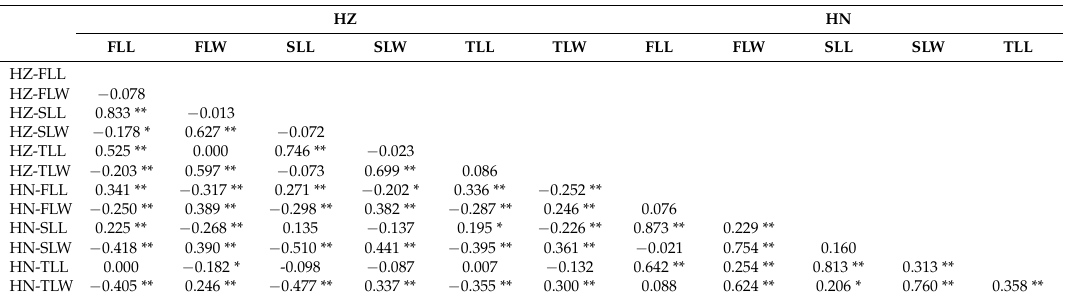
Table 1. Correlation analysis on leaf traits in recombinant inbred lines (RILs) derived from the cross of CJ16 and C84.